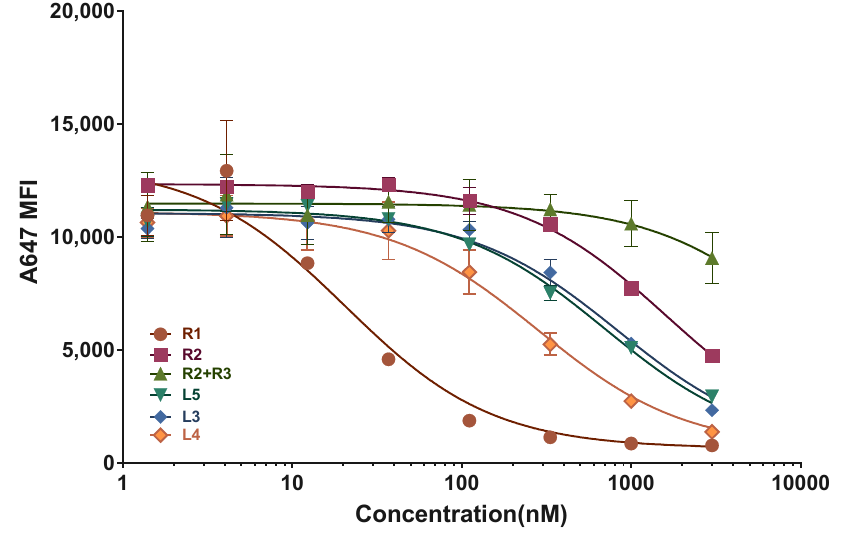
Figure 5. Affinity binding to ASGPR in primary mouse hepatocytes of gapmers and RNA derivatives carrying the anti-luciferase and anti-mTTR (Table S2) sequences. Table 4. Binding affinity to ASGPR using a mouse primary hepatocytes fluorescence-based assay [12,14].